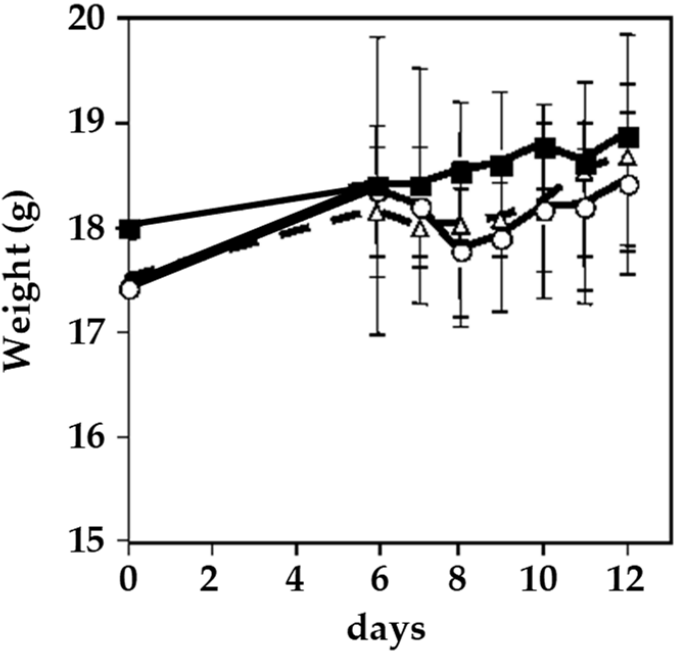
Figure 6. Effect of Phx-3 on the body weight of mice transplanted with B16 cells ( ○ : Phx-3 △ : positive control ■ : negative control). Source: Miyano-Kurosaki et al. [51] by permission from Biol. Pharm. Bull .